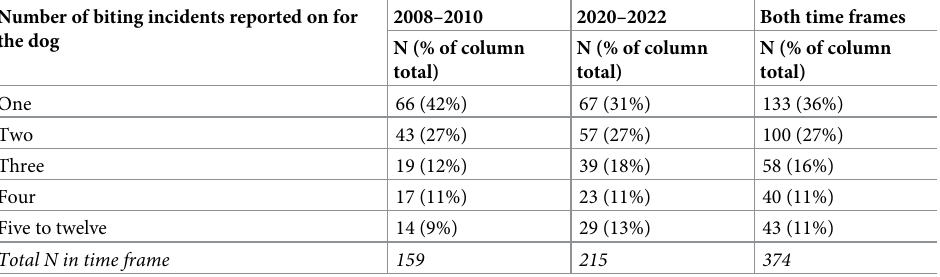
Table 8. Descriptive data on the number of biting incidents reported for dogs in 374 confiscated dogs. Descriptive data on the number of biting incidents reported for dogs in 374 confiscated dogs, as counts and as % of column total for a first time frame (2008–2010, tf1), a second time frame (2020-mid-May 2022, tf2) and overall for both time frames. Pairwise comparisons between tf1 and tf2 revealed a significantly lower count for dogs confiscated after a first biting incident in tf2 ( χ 2 = 4.2, P = 0.04, df = 1, residual -2.1). We found a contrasting significantly higher count for dogs con- fiscated after � 3 biting incidents in tf2 (42%) than tf1 (32%; χ 2 = 4.6, P = 0.03, df = 1, residual 2.1). Note that the inci- dent number includes the last incident that resulted in the dog’s confiscation.